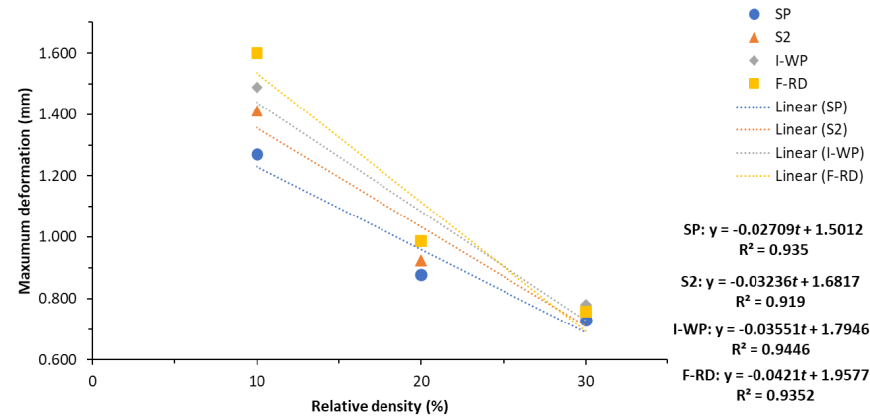
Figure 9. Deformation distribution of SPSs with SP lattice cores.